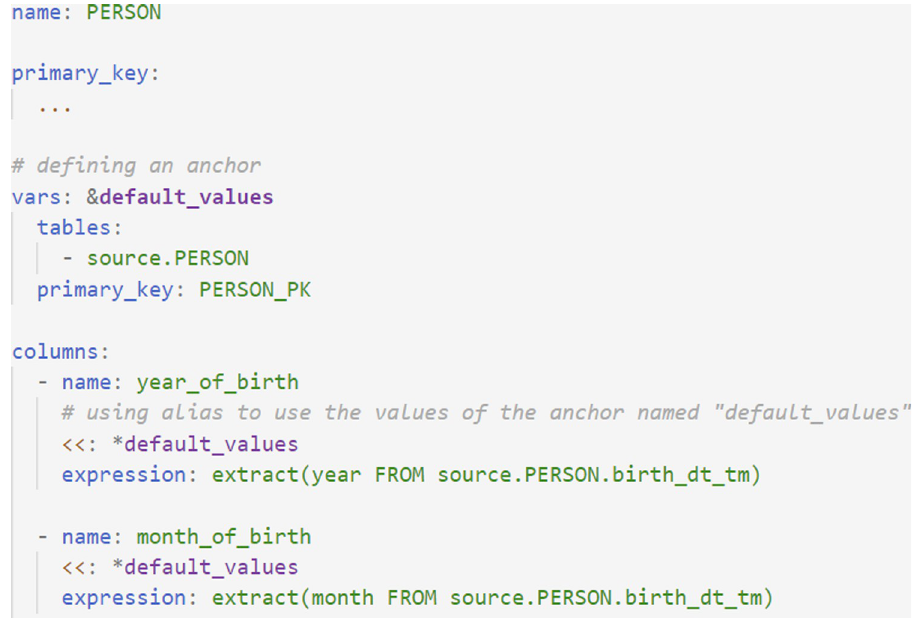
Fig 6. Use of YAML anchors and aliases. Rules for mapping from the CERNER PERSON table to the OMOP PERSON table, using YAML anchors to define a set of default values to be used by the column